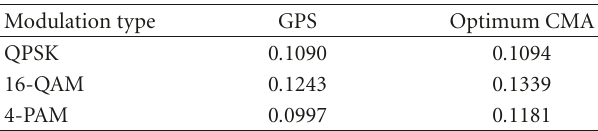
Table 2: Averaged r.m.s. EVM values using the proposed algorithm and CMA with optimum delay index δ † , for three modulation